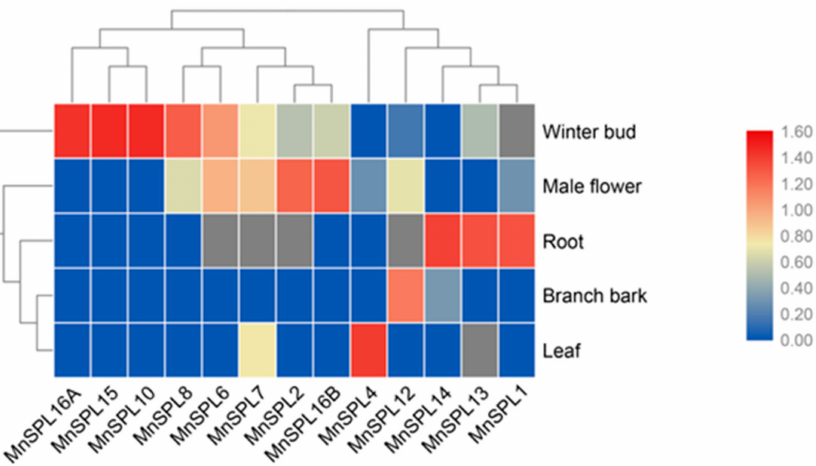
Figure 5. Tissue-specific expression patterns of MnSPL genes. Transcriptome data were obtained from the Morus Genome Database (MorusDB) (https://morus.swu.edu.cn/, accessed on 3 March 2020). Blue indicates that the expression levels of SPL genes are low, while red indicates that the levels are